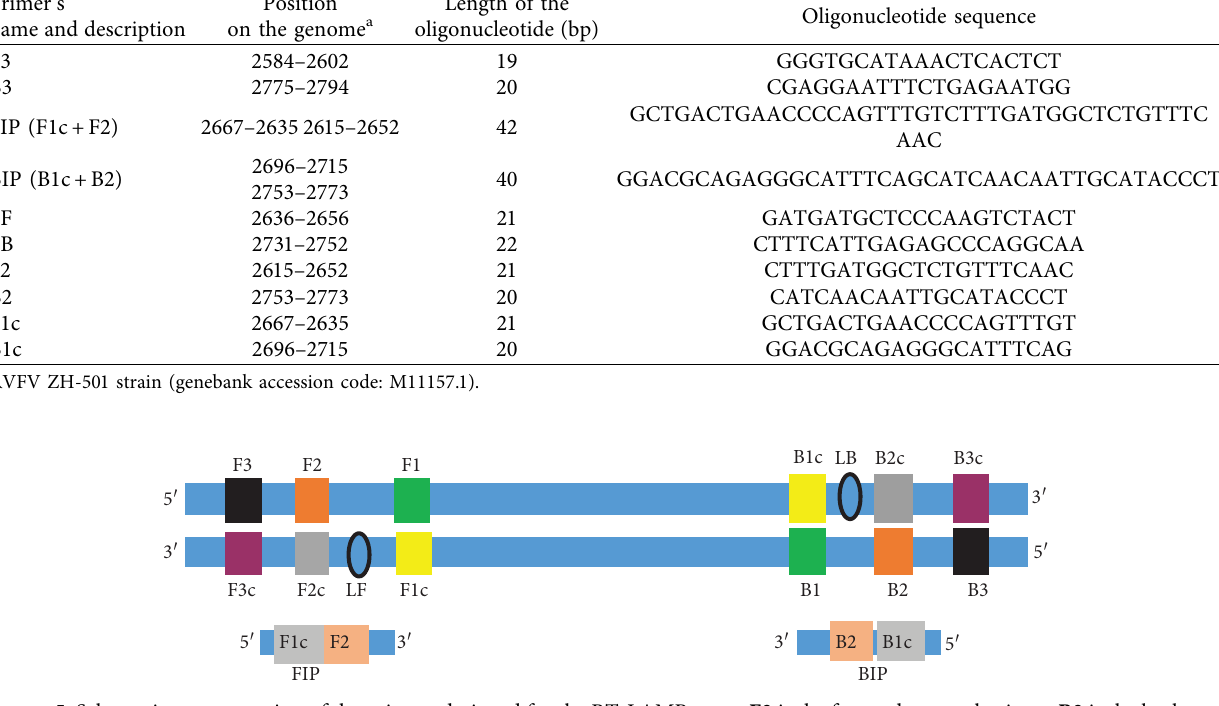
Figure 5: Schematic representation of the primers designed for the RT-LAMP assay. F3 is the forward external primer, B3 is the backward external primer, FIP is the forward inner primer, BIP is the backward inner primer, LF is the loop forward primer, LB is the loop backward primer, B1c is the complementary sequence of B1, and F1c is the complementary sequence of F1. Te inner primers FIP and BIP with both sense and antisense sequences allow the formation of a